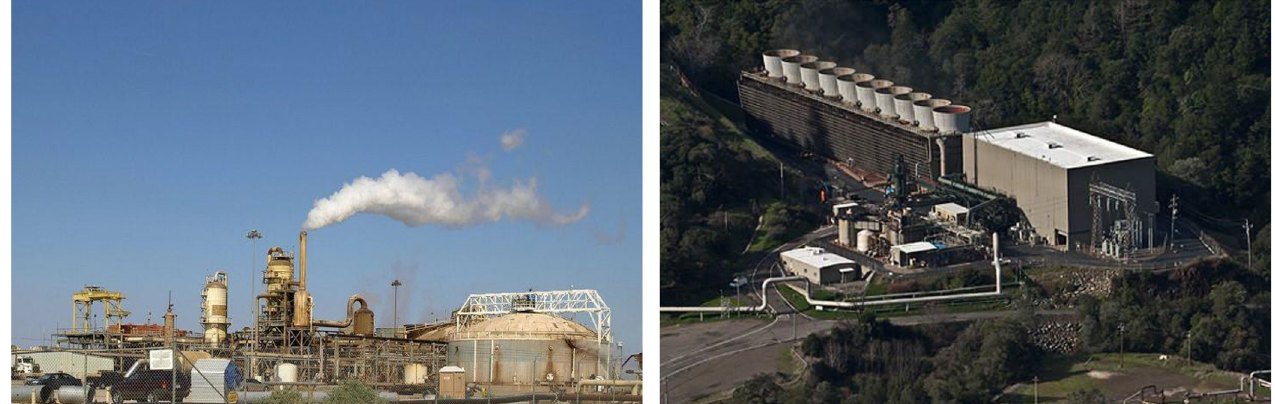
Fig. 7. USA, the Geysers Geothermal Complex